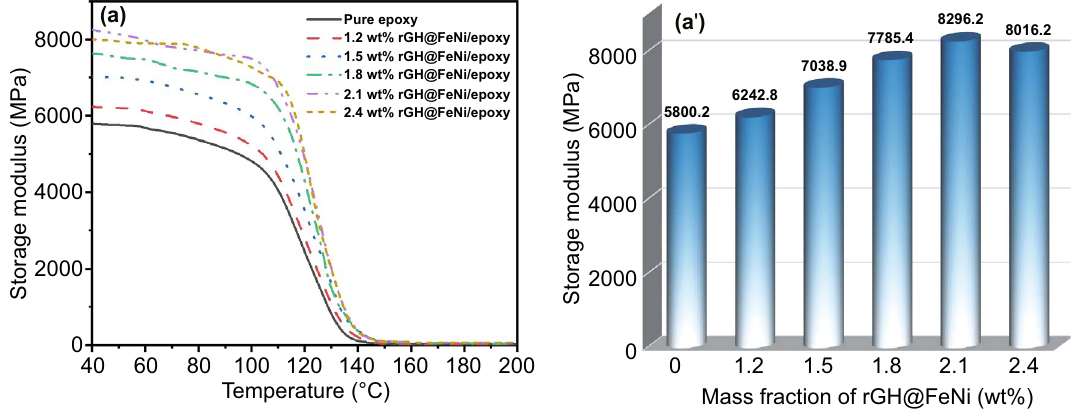
Fig. 7 DMA curves ( a ) and E s ( a ′ ) of the rGH@FeNi/epoxy